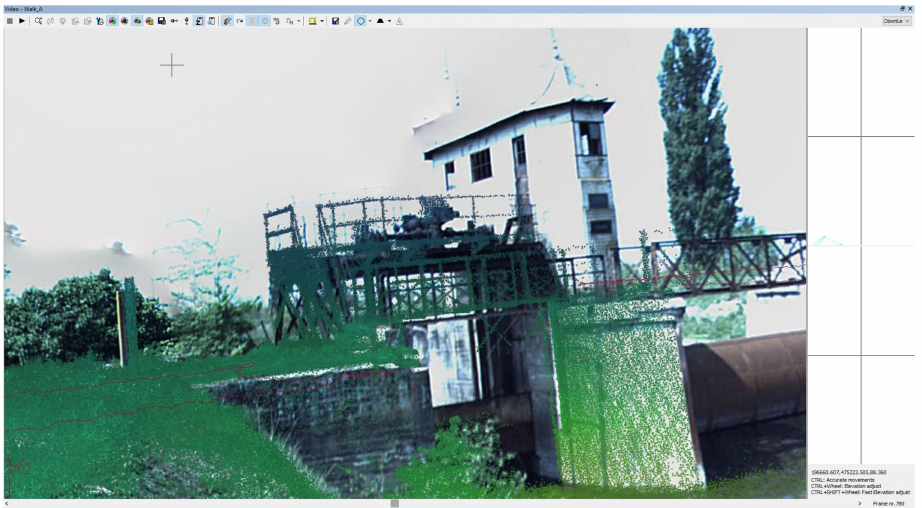
Figure 34. View the LiDAR points on the stereographic